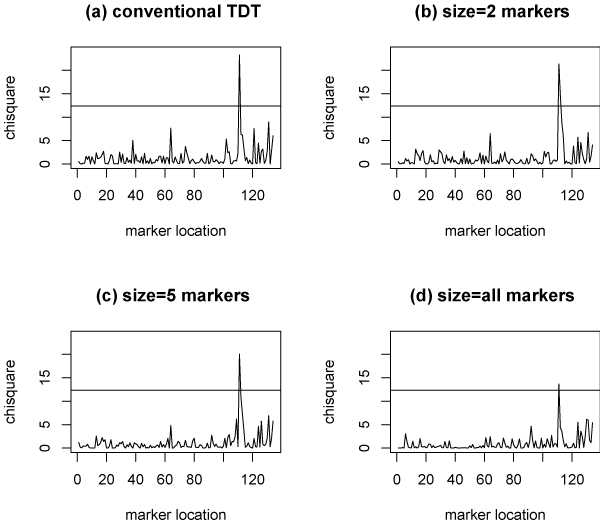
χ2 for TDT (left) and smoothed TDT (right).